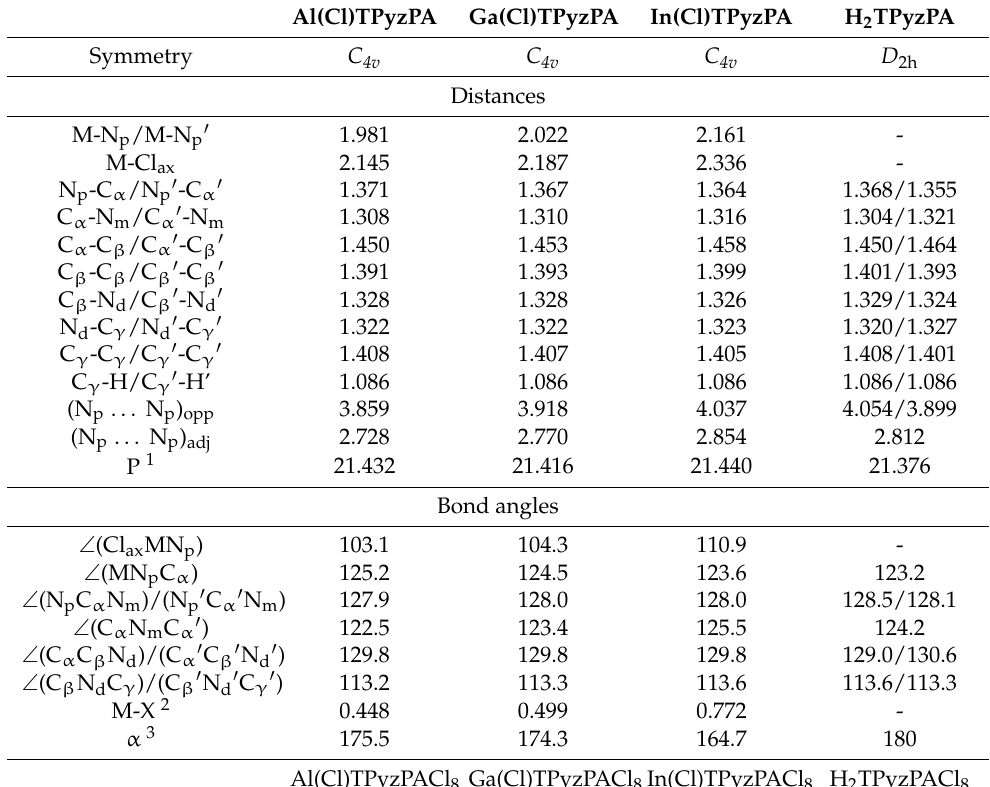
Table 1. Internuclear distances (r e , in Å) and valence angles ( ∠ , in deg.) of the equilibrium structures by PBE0-D3/def2-TZVP